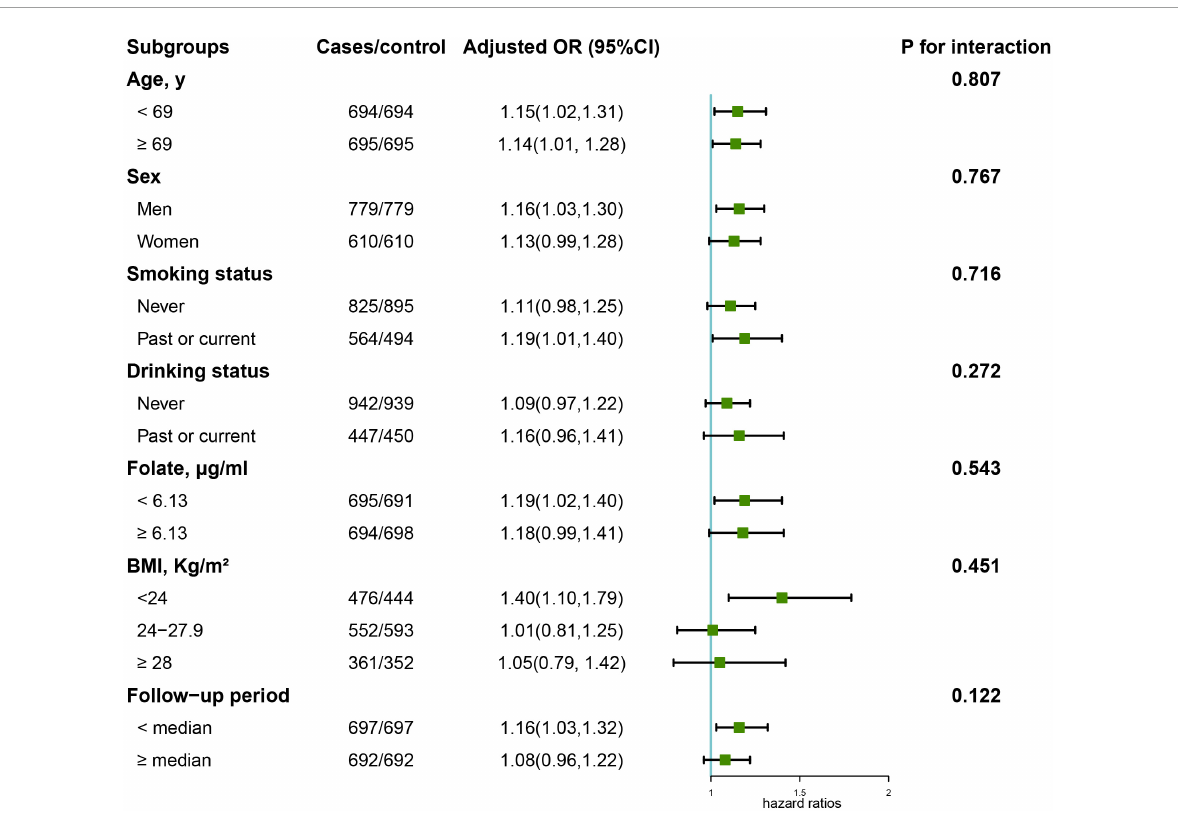
FIGURE3 Stratified analyses of the association of serum arginine (per SD) with the risk of overall cancer. Models were adjusted for BMI, smoking status, alcohol drinking, systolic blood pressure, triglycerides, cholesterol, uric acid, glucose, HDL-C, creatinine, ALB, ALT, HCY, sleep quality, antihypertensive drug usage, and family history of cancer except for the stratified